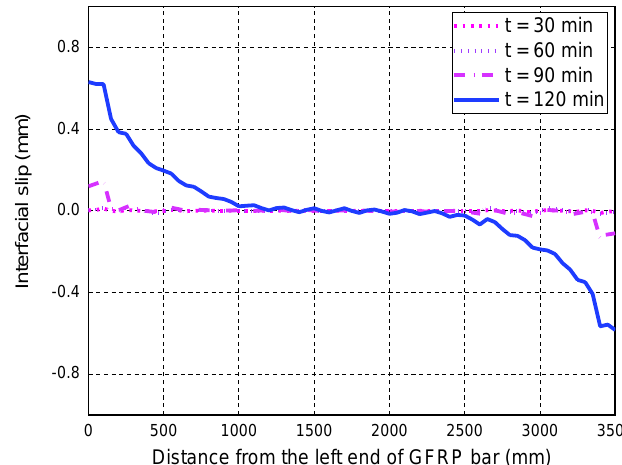
Figure 13. Effect of bond degradation on the midspan deflection responses of S3.